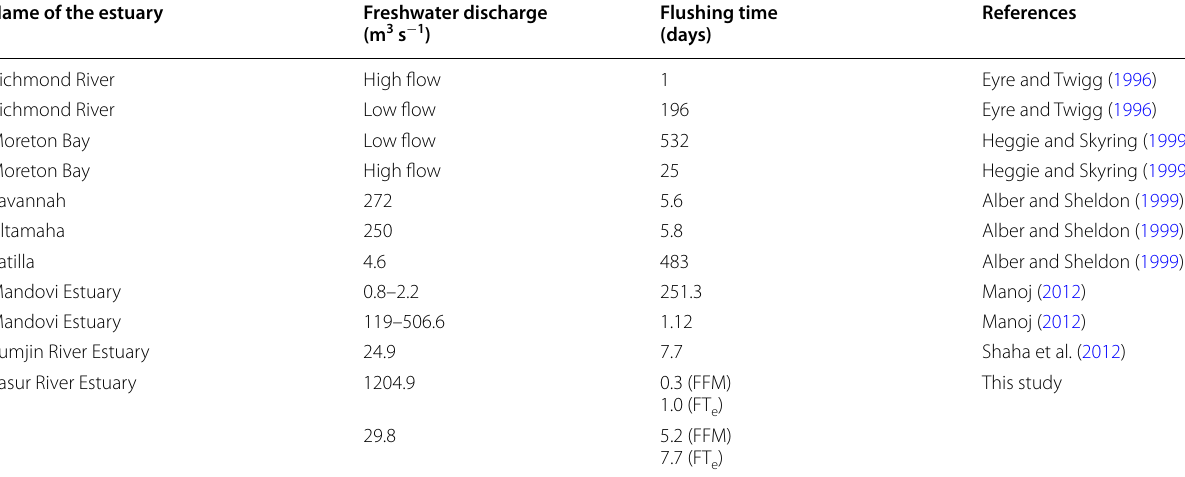
Table 2 Flushing time of different world estuaries under different freshwater discharge Name of the